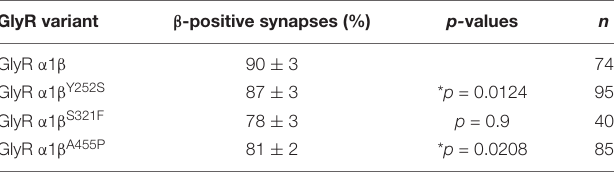
TABLE 5 | Quantification of synaptic localization of GlyR β x